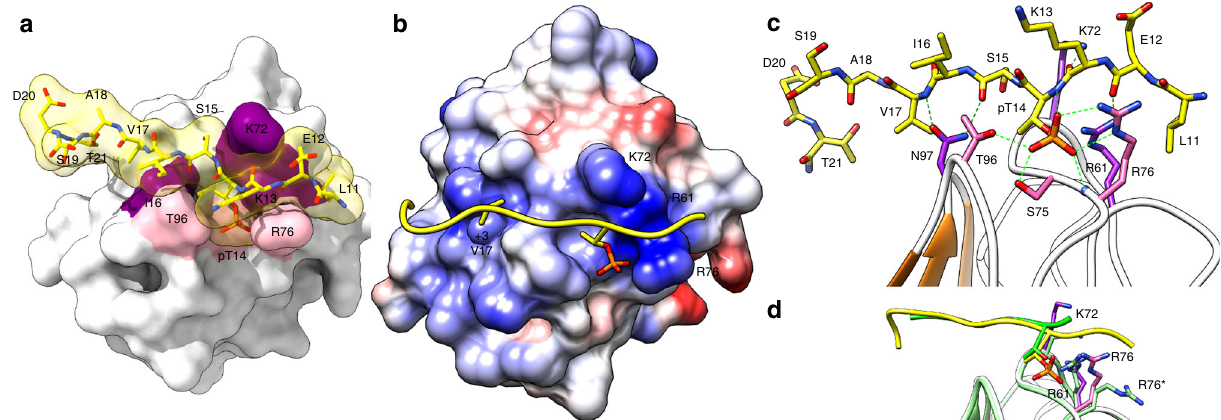
Fig. 3 Structure of liganded DgcB phosphopeptide complex (FHA domain and exogenous synthetic DgcB phosphopeptide derived from N-terminal tail sequence). a Surface representation demonstrating shape complementarity between FHA binding cleft (near side colored pink, far side purple, body of FHA fold white) and phosphopeptide (residues 11 – 20, yellow/transparent). b Charge representation of the peptide-binding cleft (coulombic surface coloring, − 10 to + 10 kcal/(mol·e), red to blue), with residues R61, K72 and R76 converging at the pThr residue. FHA substrates often use the fl anking + 3 residue as a determinant of speci fi city, as demonstrated by V17 projecting into a pocket on the FHA surface. c Hydrogen bonding contacts (green dashed lines) between the phosphopeptide and FHA domain, six of which are formed to the phosphoryl group. d Structural comparison of the non-phosphorylated (green) and phosphorylated (pink, yellow) DgcB:peptide compexes, demonstrating that the phosphorylated peptide sits relatively deeper in cleft and attracts residues R61, K72 and R76 into conformations that support phosphothreonine recognition (R76 undergoing the largest relative shift, state in non- phosphorylated complex labeled using